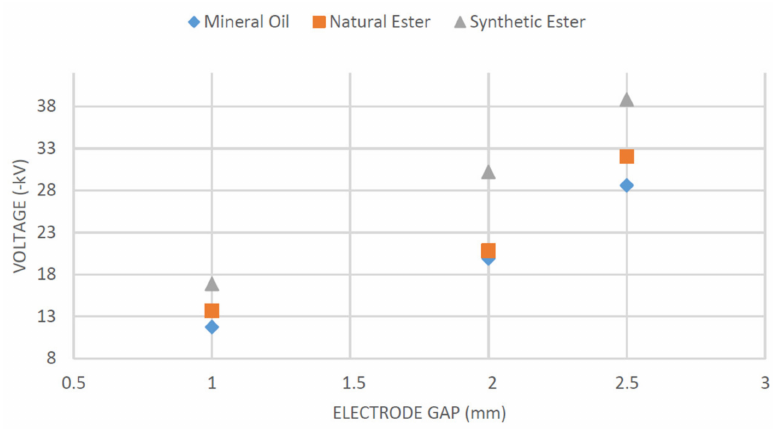
Figure 7. Negative DC BDV—disc type